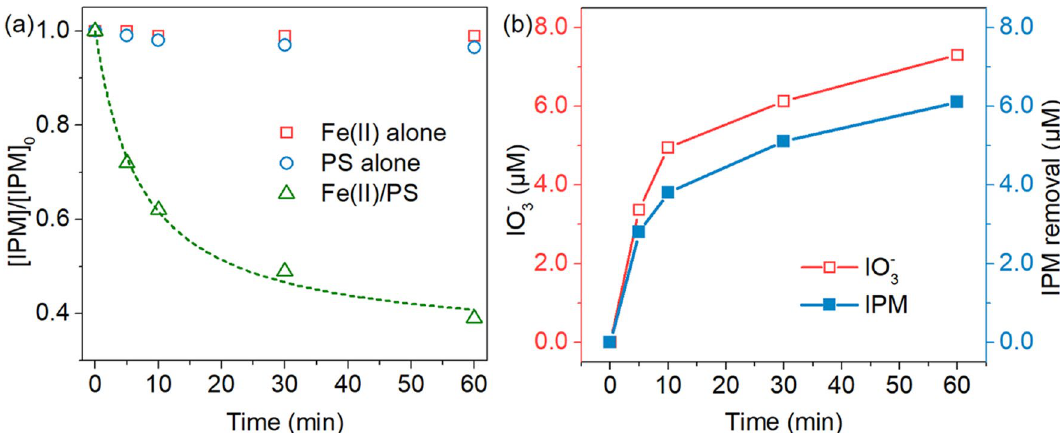
Figure 1. ( a ) IPM Degradation efficiency by PS alone, Fe(II) alone and Fe(II)/PS, respectively, and ( b ) the loss of iodine by Fe(II)/PS system under an experimental condition of a initial IPM concentration of 10 μM, a initial pH value of 3.0, at 25 °C, Fe(II) concentration of 0.1 mM and a PS concentration of 1